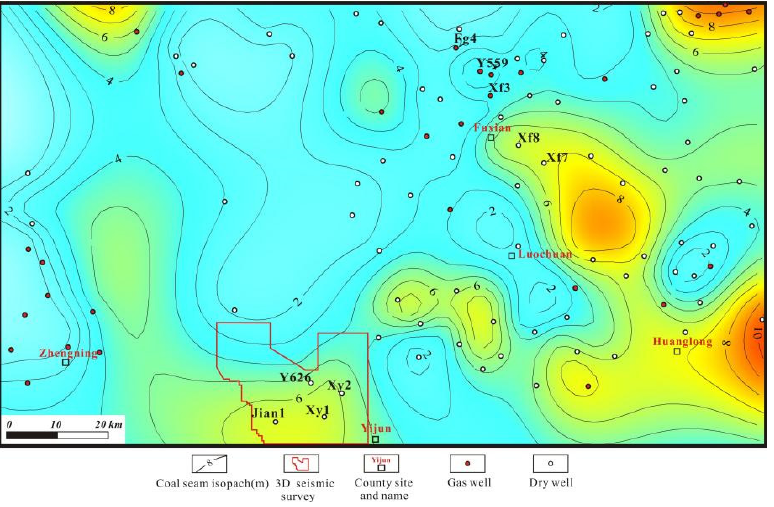
Figure 9. Total isopach map of coal seams of the Taiyuan and Shanxi Fms. in the southeastern Ordos Basin.